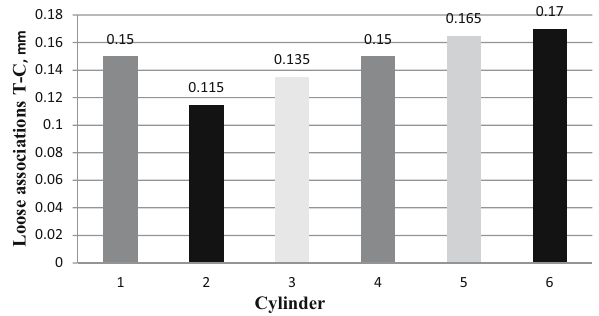
Figure 1: Characteristic loose piston – cylinder pair after 750